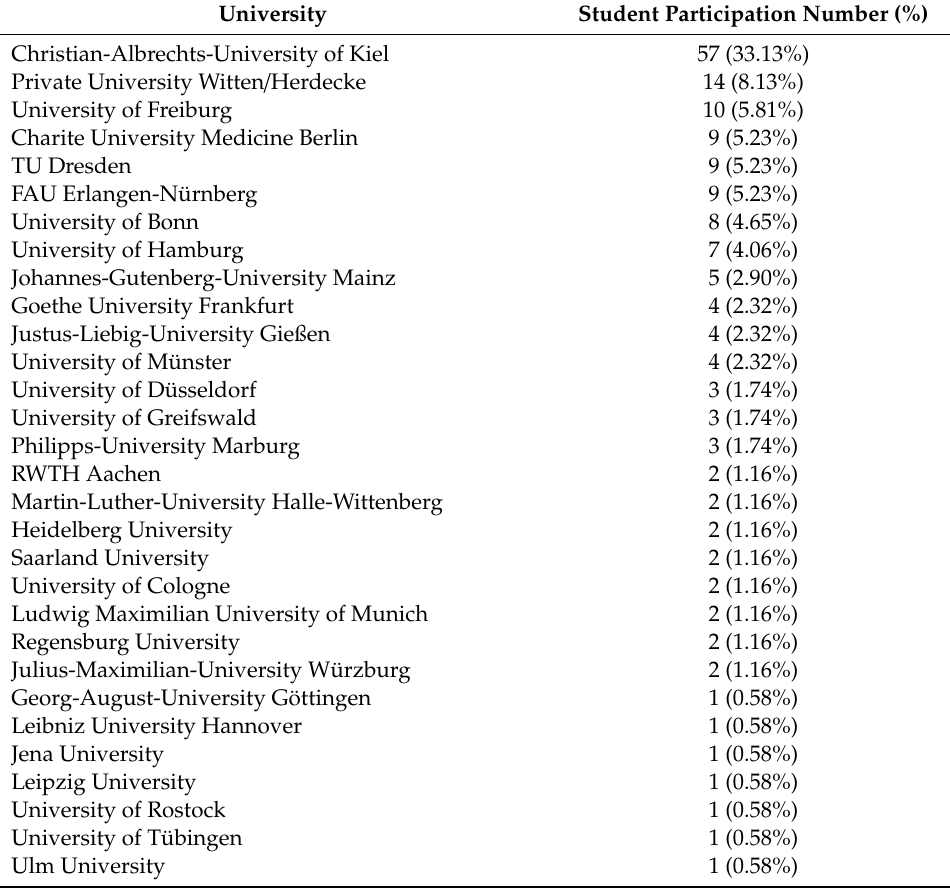
Table 3. Distribution of participating students by